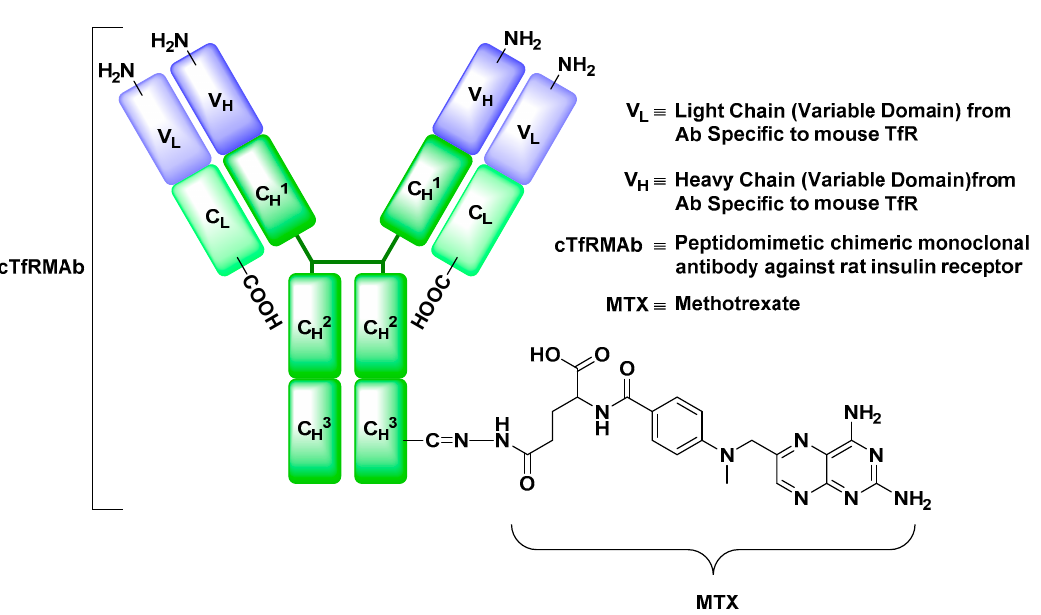
Figure 16. Structure of anti-rat transferrin receptor monoclonal antibody (TfRMAb) engineered to deliver methotrexate (MTX) to the brain by exploiting transferrin receptor-mediated transcytosis. The TfRMAb-MTX conjugate in this example was prepared by oxidation of the carbohydrate groups located on the Fc portion of the TfRMAb to form an aldehyde derivative, which was treated with a hydrazide-functionalized MTX forming a hydrazone-linker between MTX and TfRMAb.